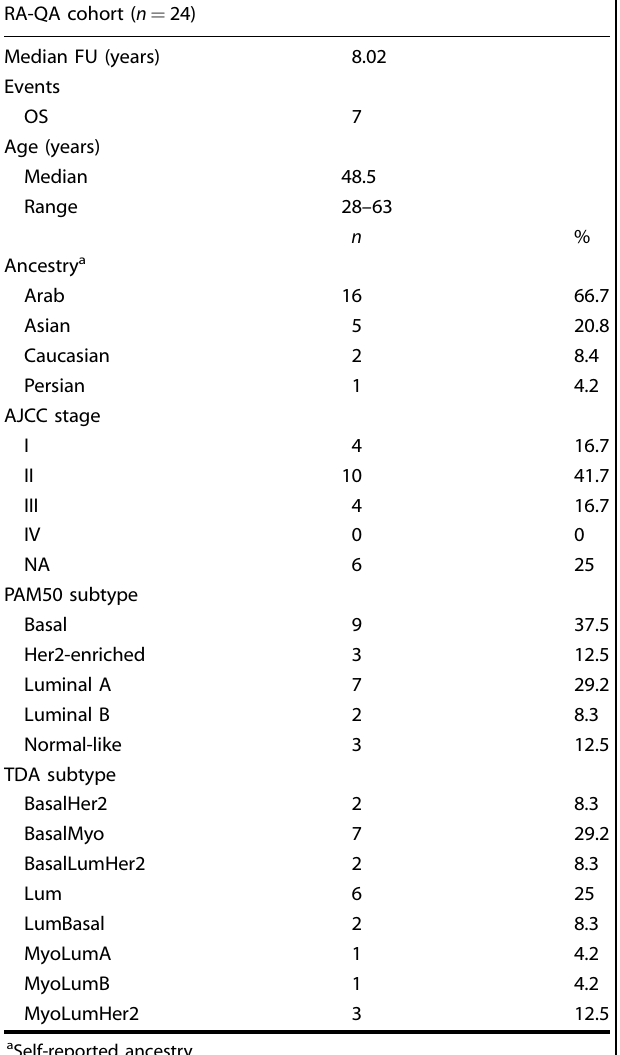
Table 2. Cohort demographics of RA-QA breast cancer